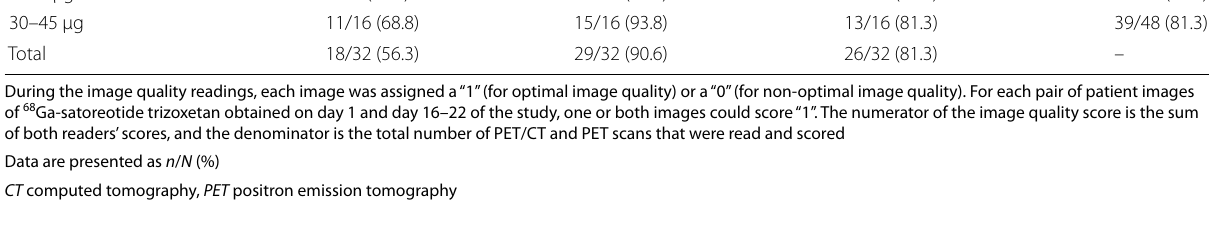
Table 3 Image quality scores for 68 Ga-satoreotide trizoxetan PET/CT and PET, by radioactivity per patient’s body weight